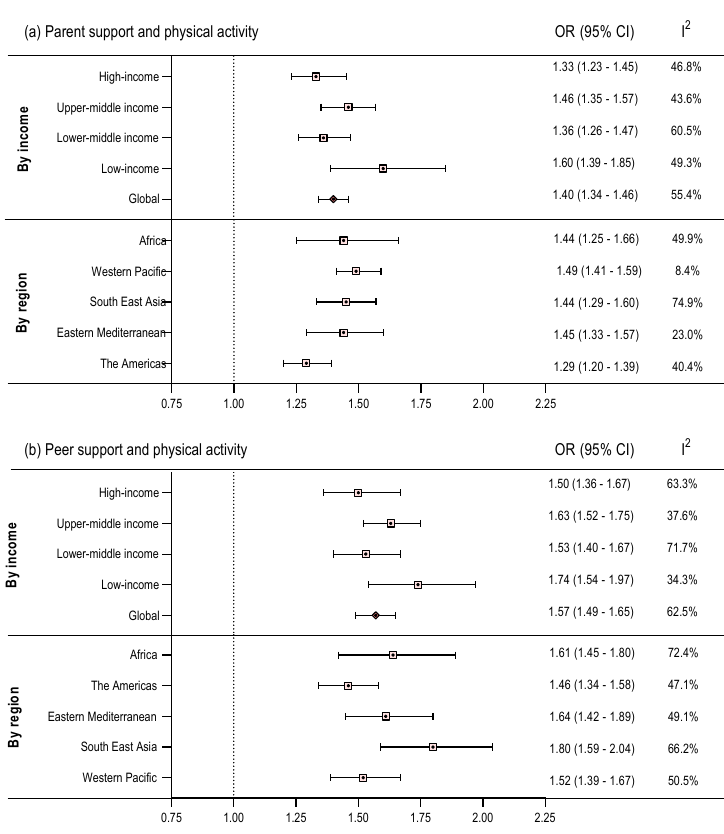
Figure 2. Pooled odds ratios (ORs) of association of high levels of ( a ) parental support and ( b ) peer support with su ffi cient physical activity among adolescents aged 11–17 years, by World Bank country income classification, and WHO region, Global School-based Student Health Survey, 2007–2016. [I-squared represents variation in e ff ect size (OR) attributable to